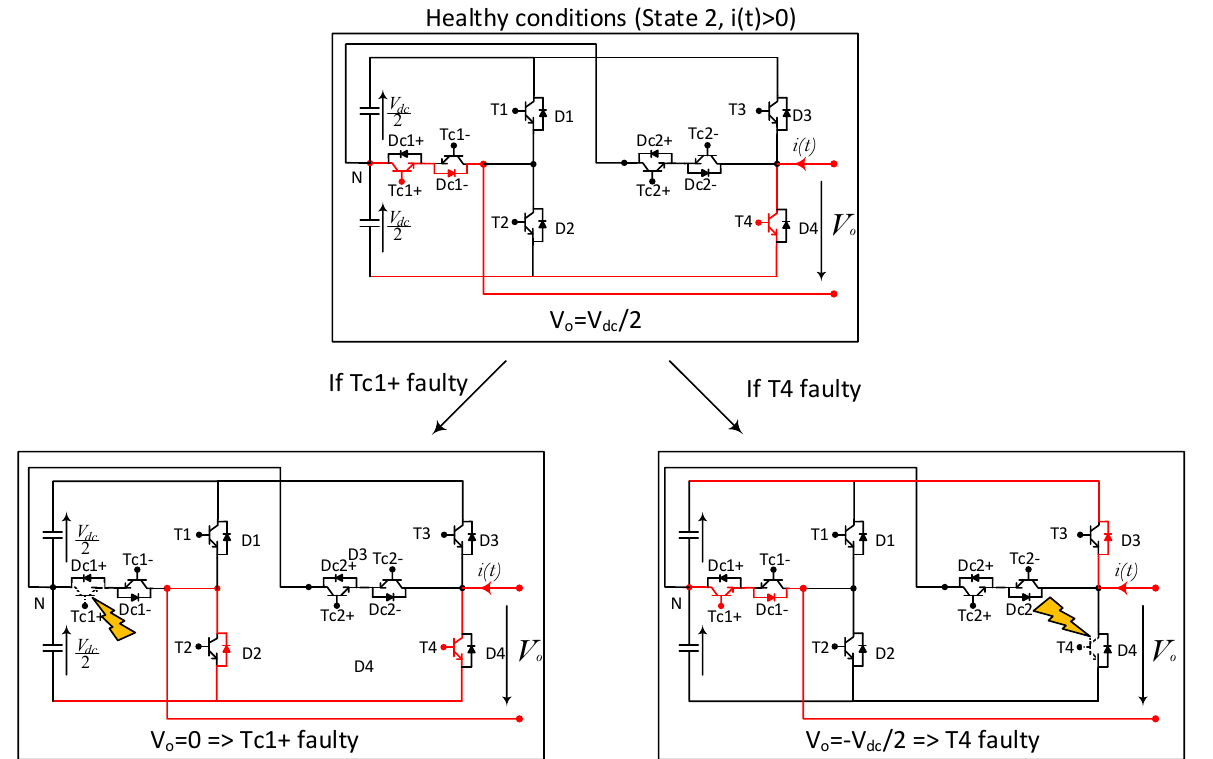
Fig. 4. Open switch fault diagnosis in State 2